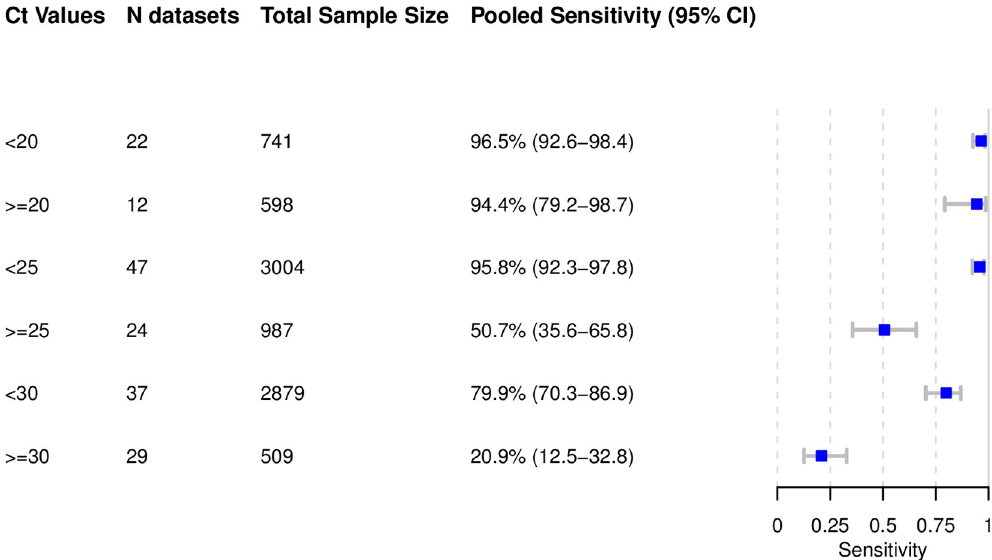
Fig 6. Pooled sensitivity by cycle threshold (Ct) values. Low Ct values are the reverse transcription PCR semi-quantitative correlate for a high virus concentration.